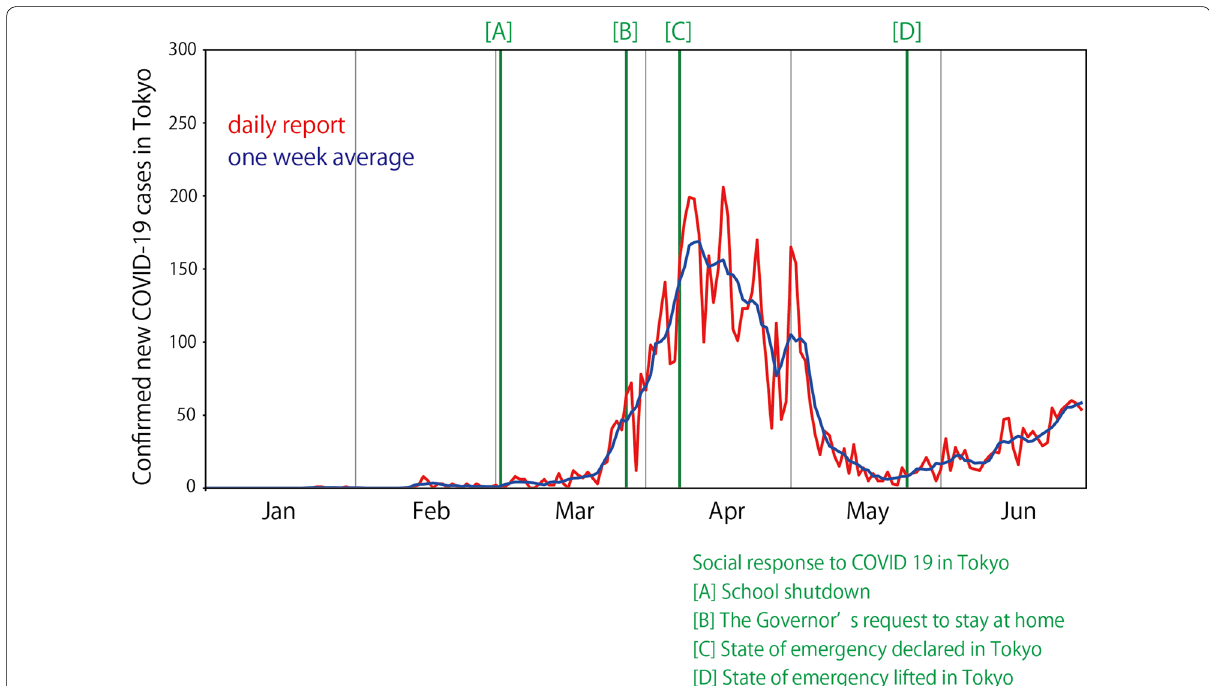
Fig. 2 Timeline of COVID-19 in Tokyo. The red curve shows the daily reported number of confirmed new COVID-19 cases in Tokyo. The blue curve is smoothened using a 1-week time window. Green lines indicate the timing of government actions for